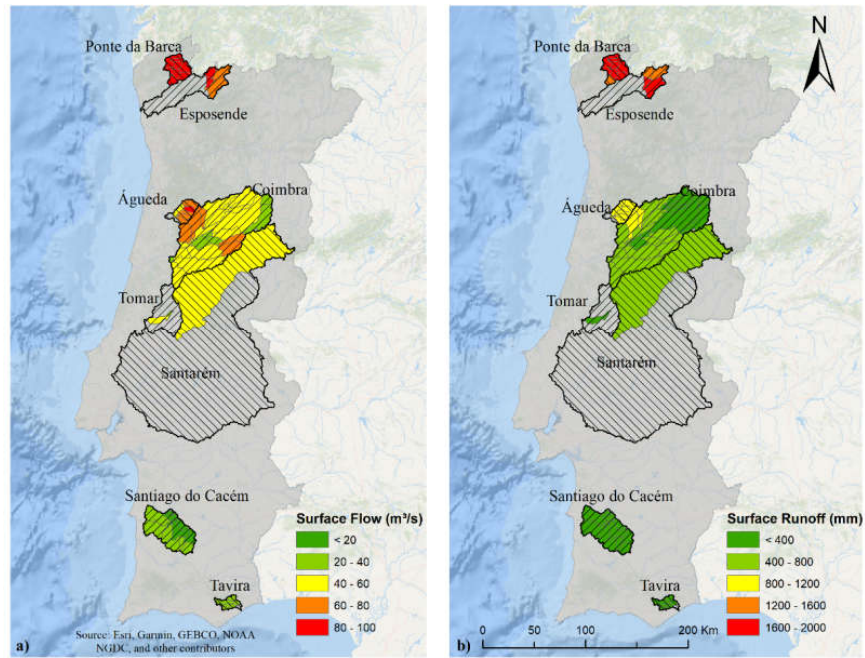
Figure 7. Spatial distribution of Surface Runoff. Only the variables used in the PLS-PM analyses are represented, namely: ( a ) Surface flow expressed as total surface discharge (m 3 /s); ( b ) surface runoff expressed as surface discharge normalized by catchment area.